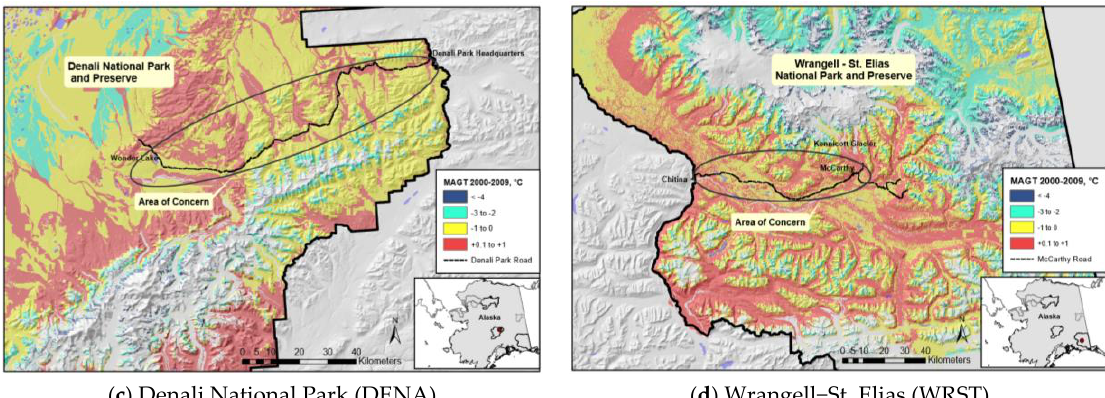
Figure 2. ( a ) Map of mainland Alaska showing the location of three National Park Service (NPS) units, the road of interest (colored lines) inside each, and location of the NPS surface stations, and ( b ) Mean annual ground temperature (MAGT) in Gates of the Arctic, ( c ) MAGT in Denali, and ( d ) MAGT in Wrangell-St. Elias. MAGT values are for 2000 – 2009 and areas of concern in each park are indicated. Permafrost mapping in ( b – d ) from [12 – 14].